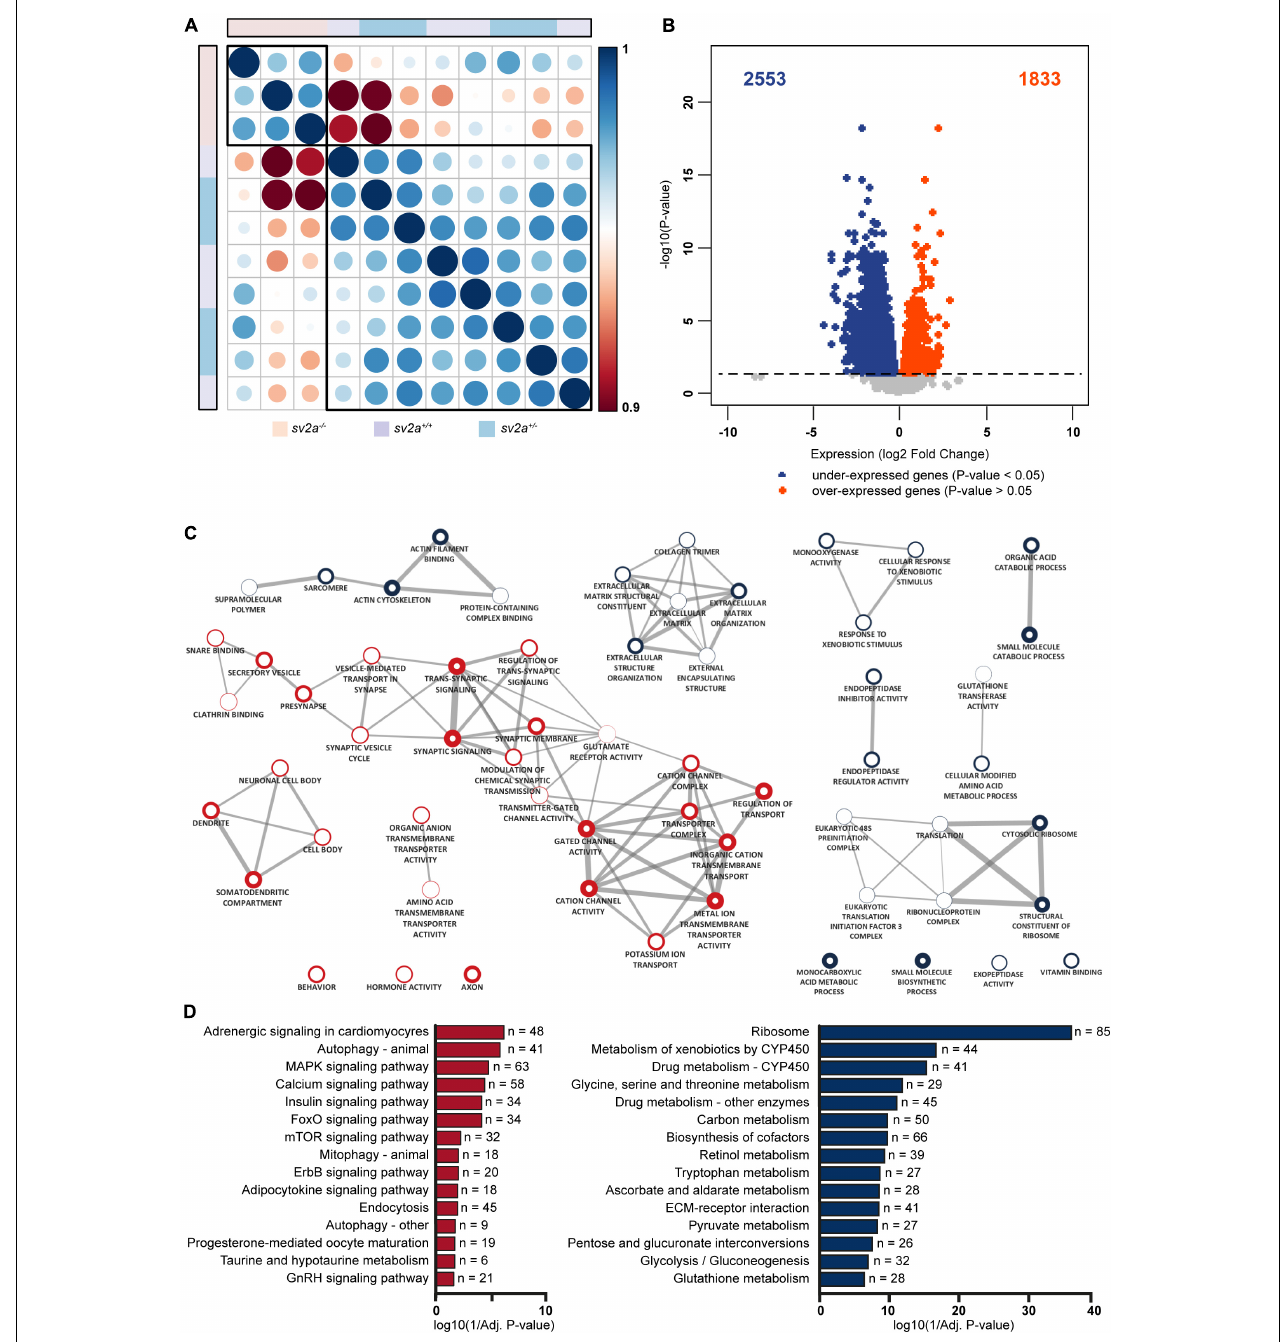
FIGURE 4 | Transcriptome analysis and gene ontology (GO) enrichment map of sv2a − / − larvae. (A) Spearman’s rank correlation matrix of the RNA-Seq data showing separate clustering of sv2a − / − samples from sv2a + / + and sv2a + / − samples. Scale bar indicates the strength of the correlation, with 1 indicating a strong positive correlation (dark blue) and 0.9 indicating weak correlation (dark red) between samples. Areas of the circles show absolute values of corresponding correlation coefficients. Samples of different genotypes are indicated in distinct colors codes. (B) Volcano plot showing the differentially expressed genes (DEG) (padj < 0.05) between sv2a − / − and sv2a + / + larvae. Of the 4386 DEGs, 2553 were found to be down- (blue) and 1833 to be up-regulated (red) in sv2a − / − larvae compared to sv2a + / + . (C) GO enrichment map from up- and down-regulated genes between sv2a + / + and sv2a − / − zebrafish larvae. Each node represents a different GO term, the red and blue outside of nodes indicate enrichment in up- or down-regulated genes, respectively. The larger the node the greater the number of genes in the enriched GO term. Connecting lines indicate common genes shared between nodes, the thicker the line the more genes in common. (D) Enriched pathways from differentially expressed genes between sv2a − / − and sv2a + / + zebrafish larvae. Pathways enriched amongst up-regulated genes are indicated in red, pathways enriched amongst down-regulated genes are indicated in blue. The x-axis represents the log10 (1/ p -value), n indicates the number of genes appearing in each category.